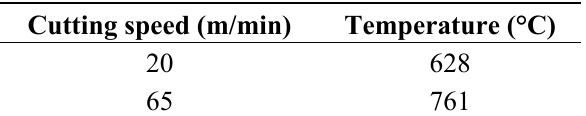
Table 5. Mean temperature obtained by infrared camera technique (Cedip camera) when machining Ti-55531 with tool “A”, rake angle